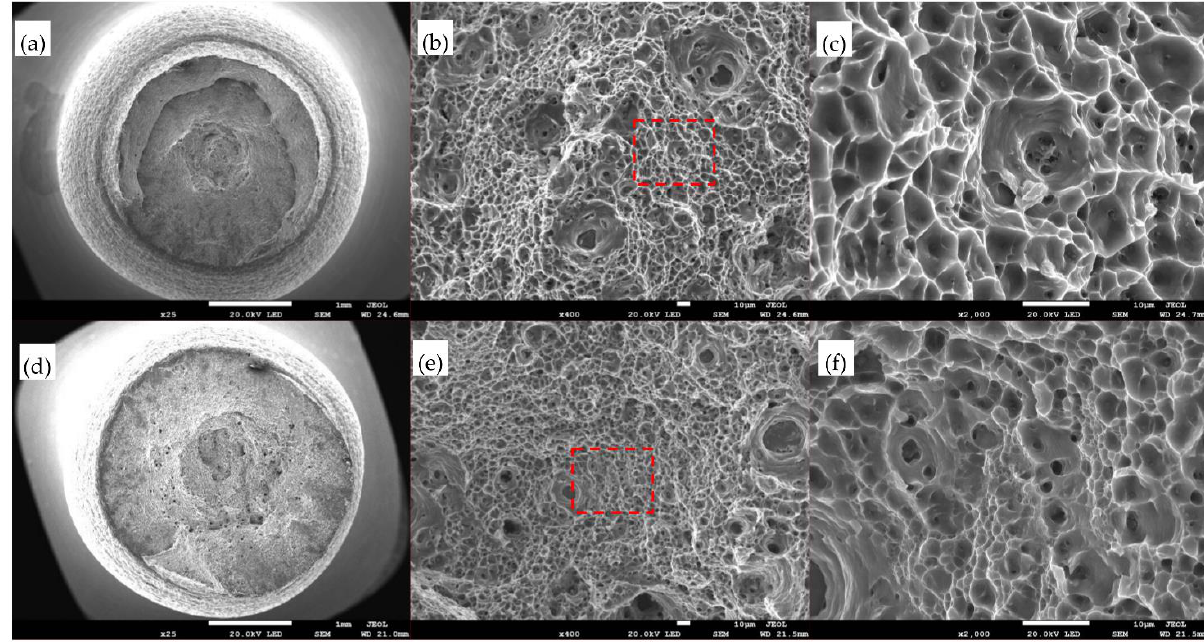
Figure 6. SEM micrographs of tensile fracture morphology of alloy 1 ( a – c ) and alloy 2 ( b – f ) after hot extrusion: ( a , d ) macro fracture; ( b , e ) high magnification; ( c , f ) high magnification of the dashed parts of ( b , e ).